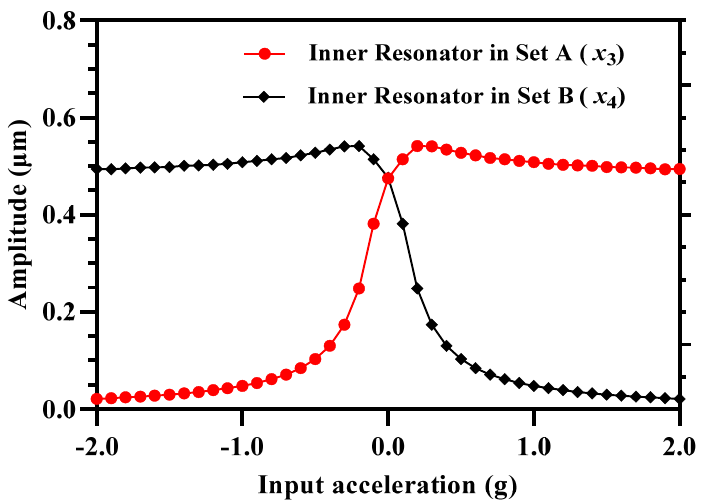
Figure 15. Vibration amplitude of inner resonators in both 3-DoF resonator Set A and Set B with increasing value of input acceleration.